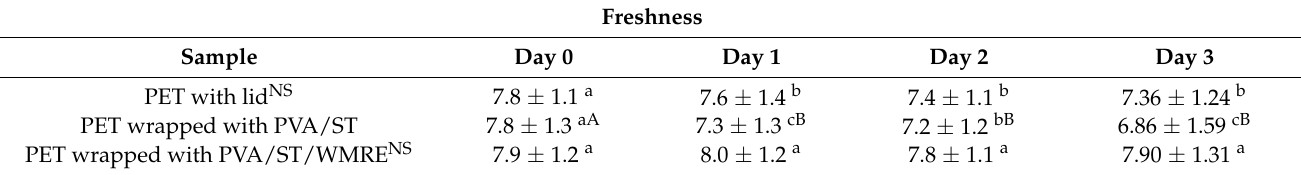
Table 6. Mean liking score and standard deviation of freshness of fresh-cut purple cabbage (n =